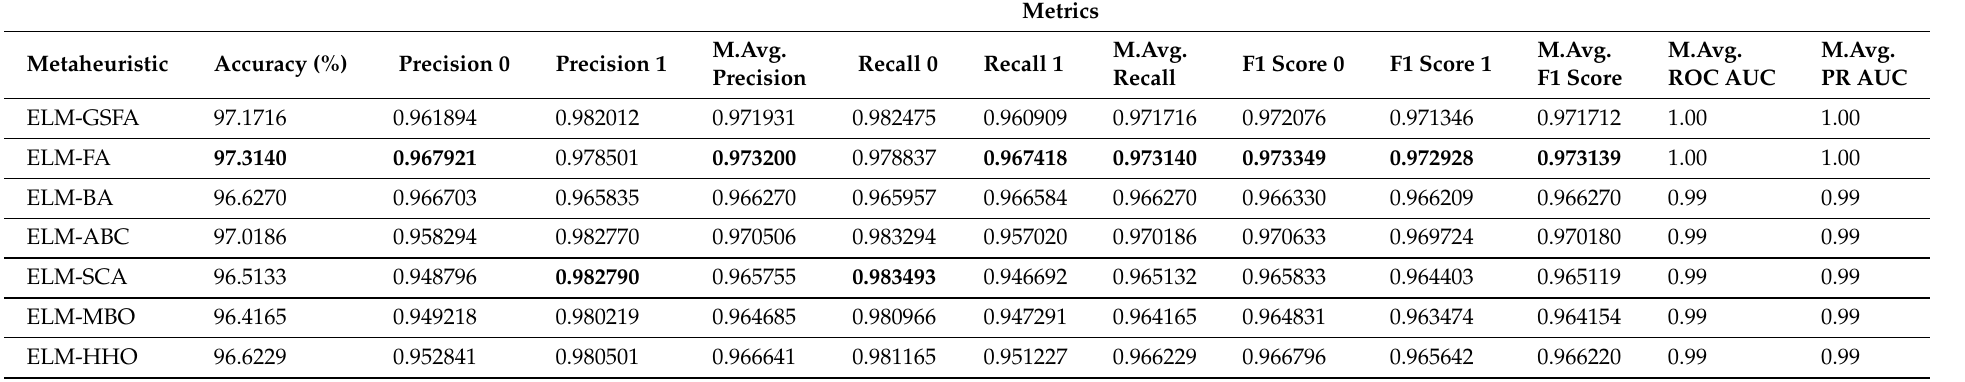
Table 12. ELM Credit Card Fraud with the SMOTE—detailed